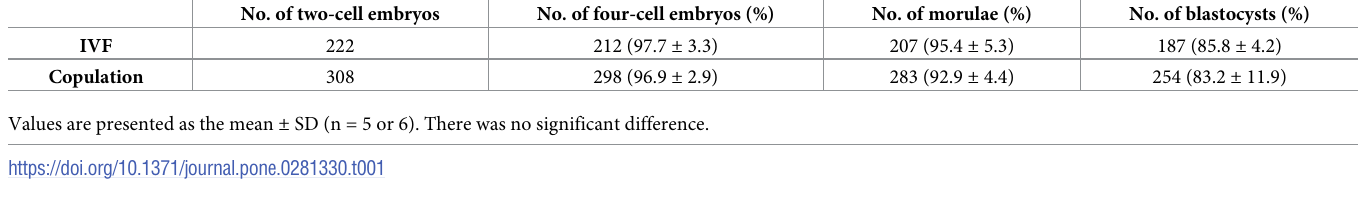
Table 1. In vitro developmental ability of embryos obtained via postovulatory copulation. No. of two-cell